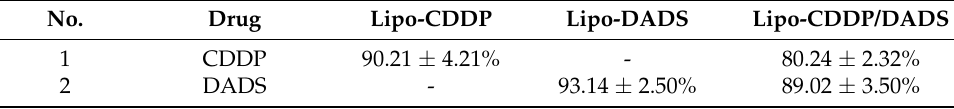
Table 2. Encapsulation efficiency of formulated nanoliposomes.